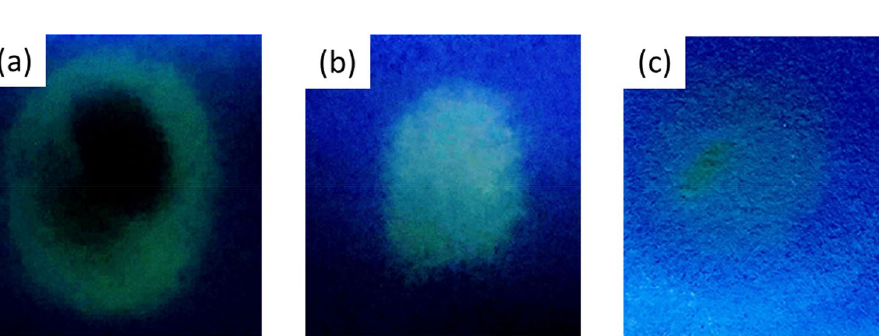
Figure 4. Image of paper substrate collection surface (i.e., target) whereby 0.1 M of dansyl chloride and 0.1 M aniline solution were sprayed from: ( a ) single tip, ( b ) dual-tip and ( c ) co-axial tip arrangements at a distance of 2 cm (as labelled in the